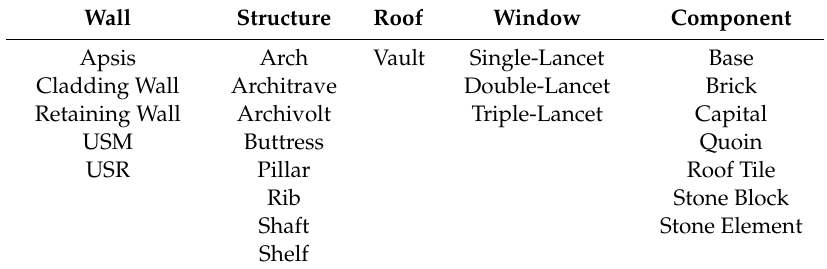
Table 1. Example of custom implementation referring to main elements of historic architecture and building archaeology. These definitions have been included on “ ifcRole ” menu of